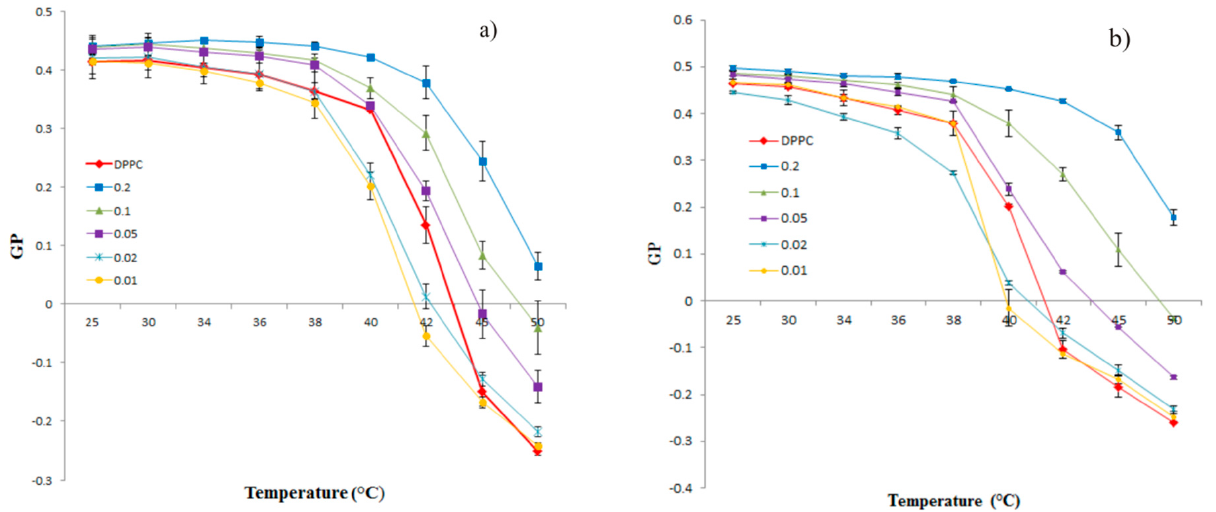
Figure 2. Values of general polarization (GP) of Laurdan in liposomes DPPC (control) and mixed liposomes: acylglycerol 5 /DPPC ( a ) and acylglycerol 4 /DPPC ( b ) in a six-molar ratio of the tested acylglycerol to DPPC (n acylglycerol /n DPPC ): 0.01, 0.02, 0.05, 0.1, and 0.2, as a function of temperature.